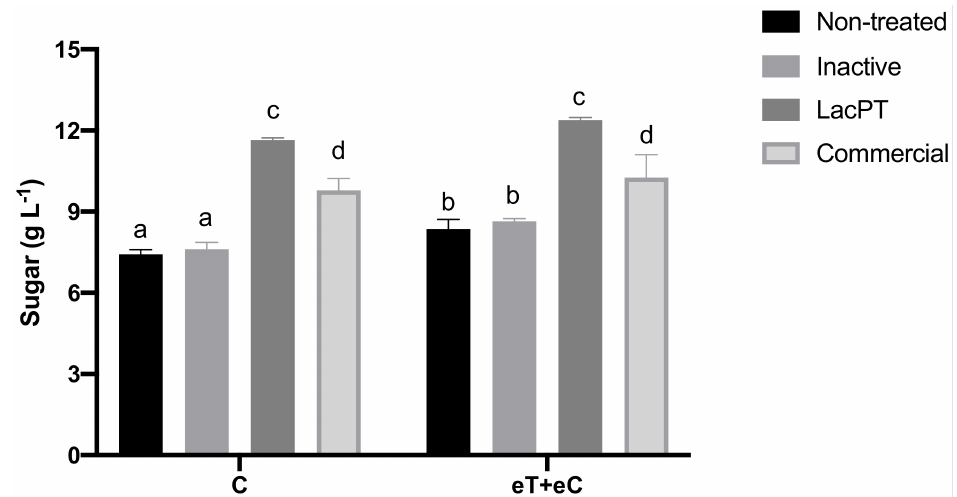
Figure 5. Sugar yield (gL − 1 ) after enzymatic hydrolysis of non-treated and pretreated by inactive crude laccase, crude, and commercial laccase. Hydrolysis conditions: 5% solid loading, 15 mg protein/g biomass for 48 h. Treatments: Control (C) and elevated temperature + elevated CO 2 (eT+eC). Mean values ± SD ( n = 3) marked with different letters above bars symbolize statistical differences among treatments ( p ≤ 0.05, Tukey’s